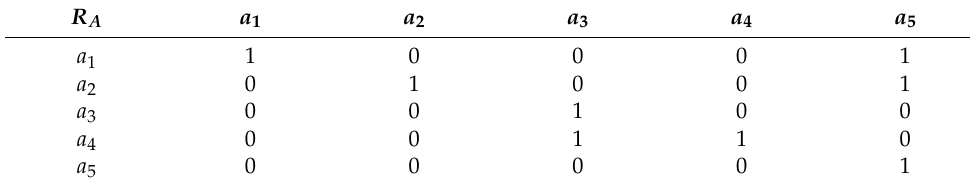
Table 4. A binary relation on A .